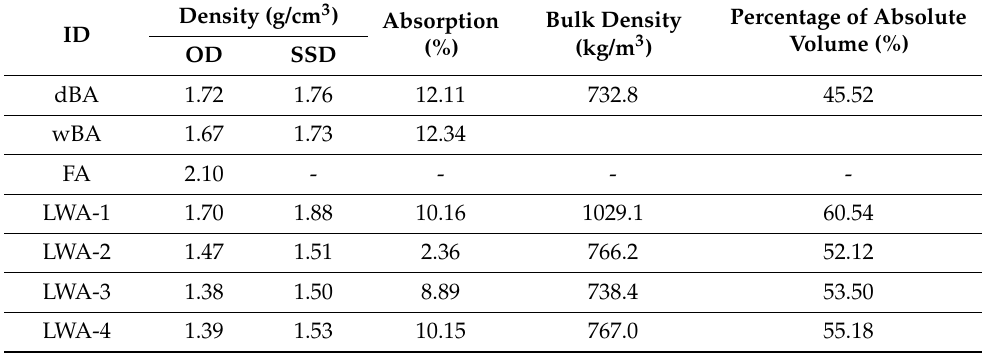
Table 4. Experimental plan and the physical properties of various artificial aggregates.